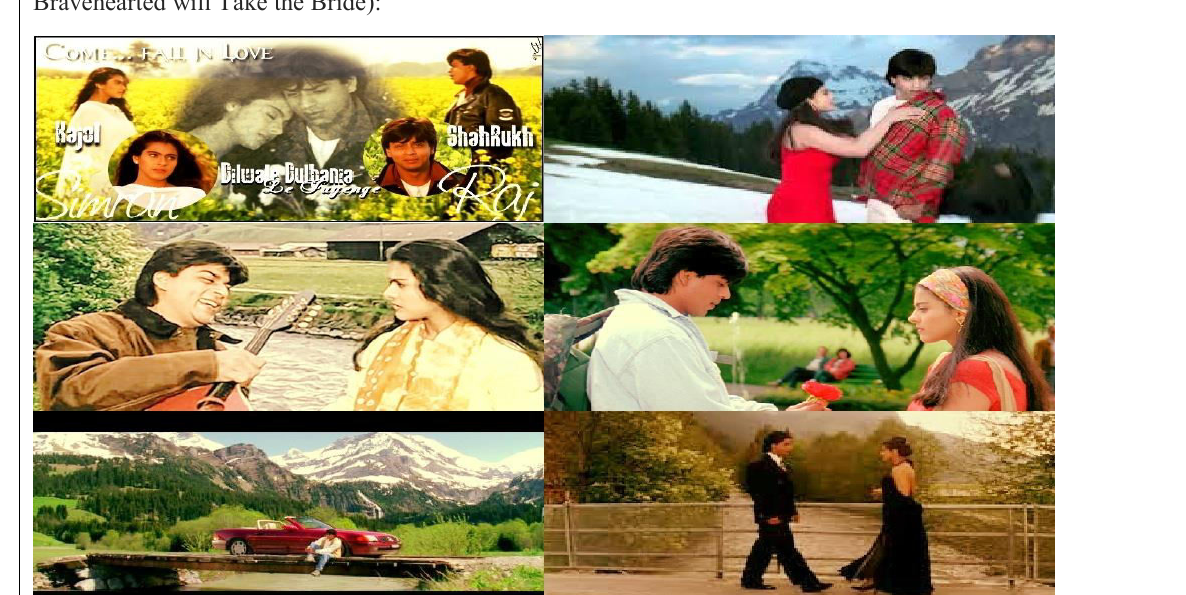
Picture 1: Screen grabs from the film Dil Wale Dulhaniya le Jayenge (1995) (The Bravehearted will Take the